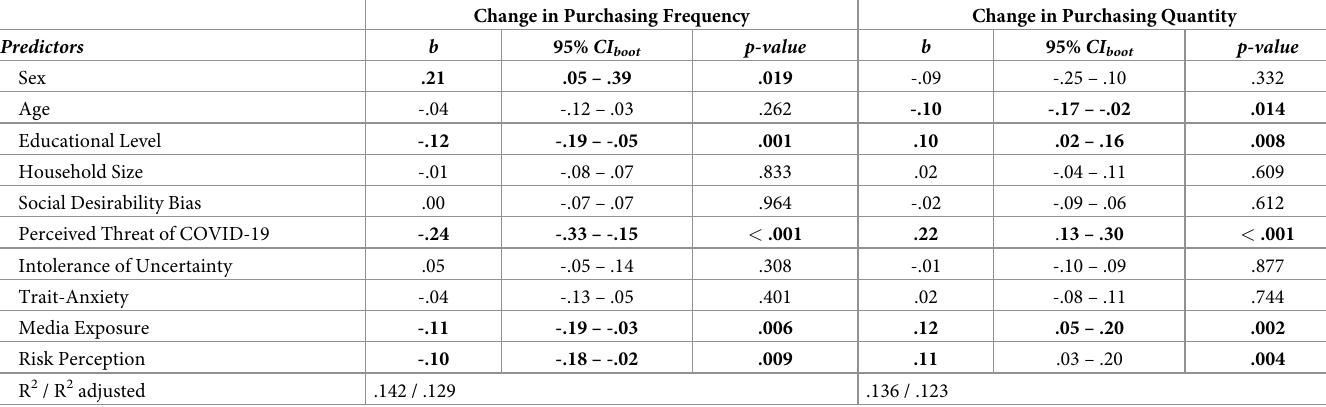
Table 3. Overall model: Prediction of change in purchasing behavior (frequency/quantity).